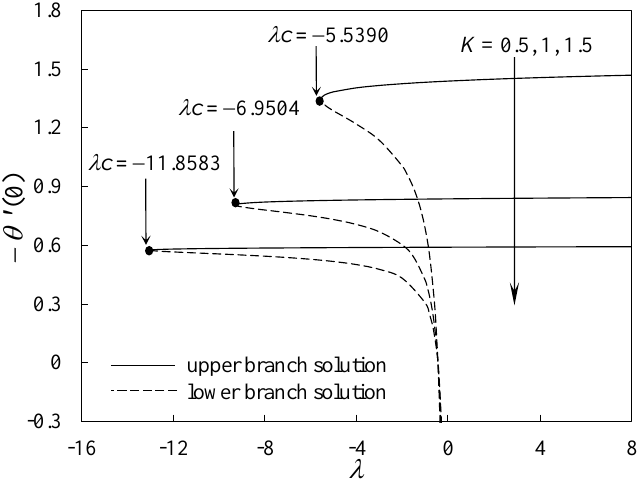
  0    0  with  for several values of K for Cu-water nanofluid. with  for several values of K for Cu-water nanofluid.